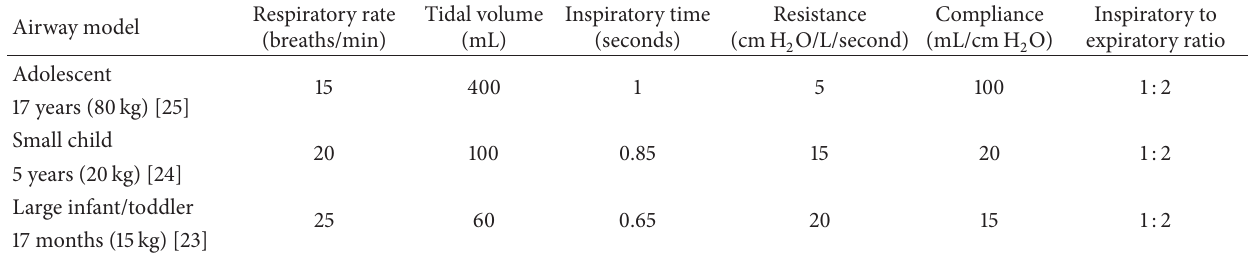
Table 1: Test lung settings used to simulate three healthy pediatric conditions.